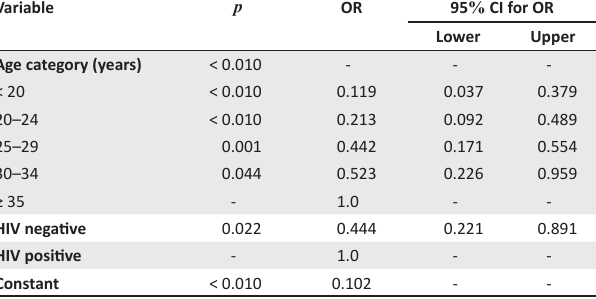
TABLE 3: Logistic regression output for human immunodeficiency virus positive at the booking visit. Variables